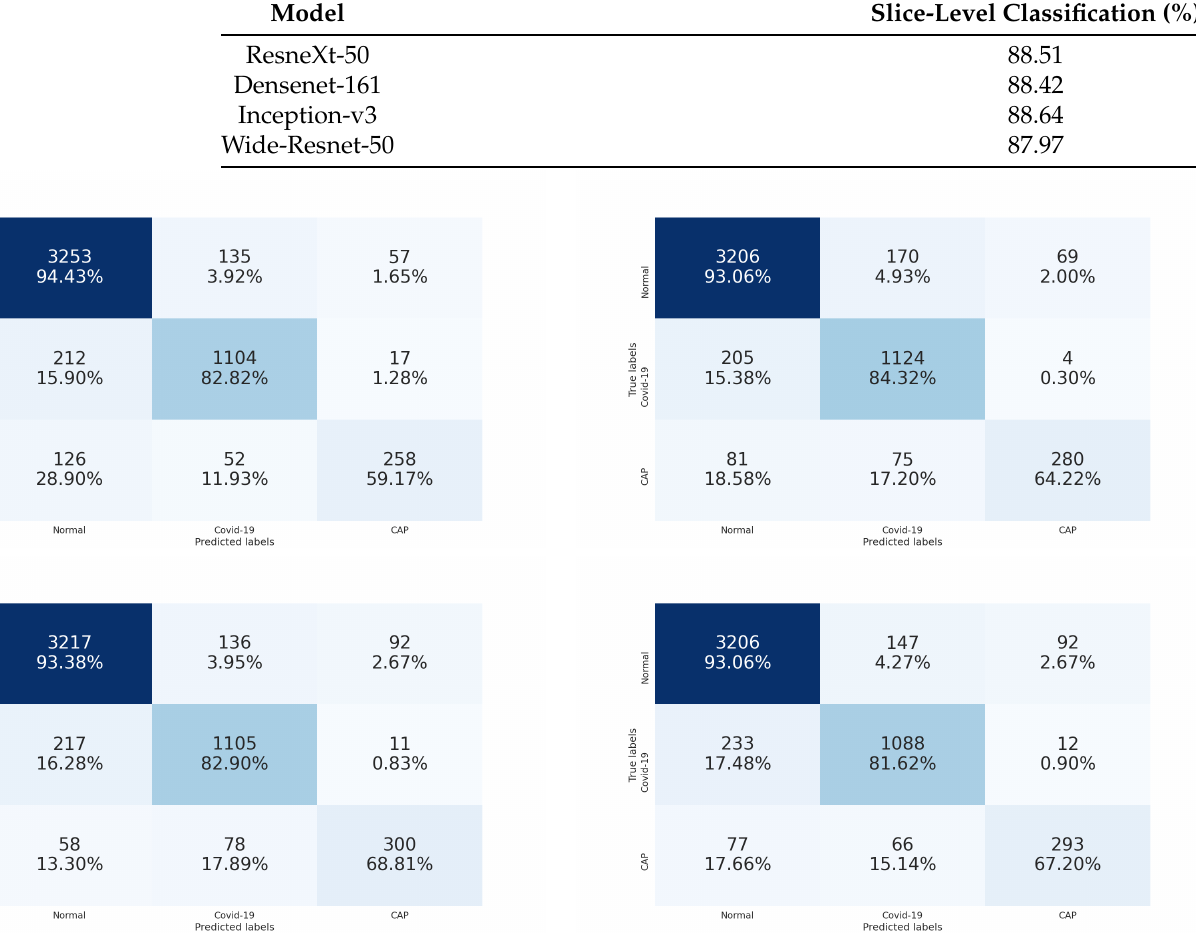
Figure 8. Confusion matrices of the augmented stacked grayscale image and the segmented lung lobes on validation data using ResneXt-50, Densenet-161, Inception-v3, and Wide-Resnet-50, respectively. The vertical axis is for the true classes, and the horizontal axis is for the predicted